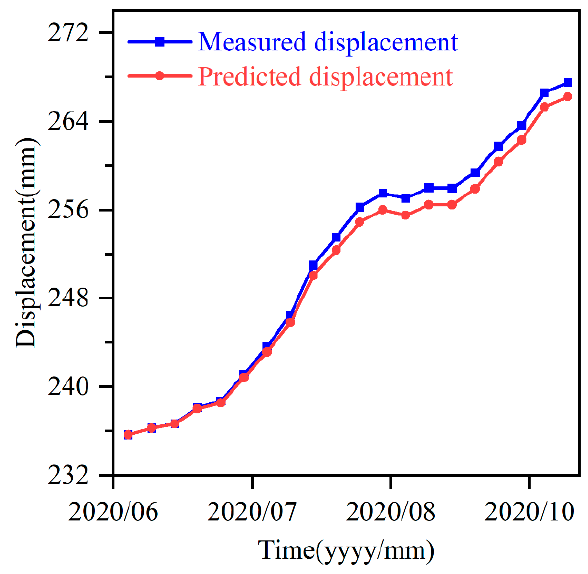
Figure 13. The cumulative displacement prediction results of the validation set.